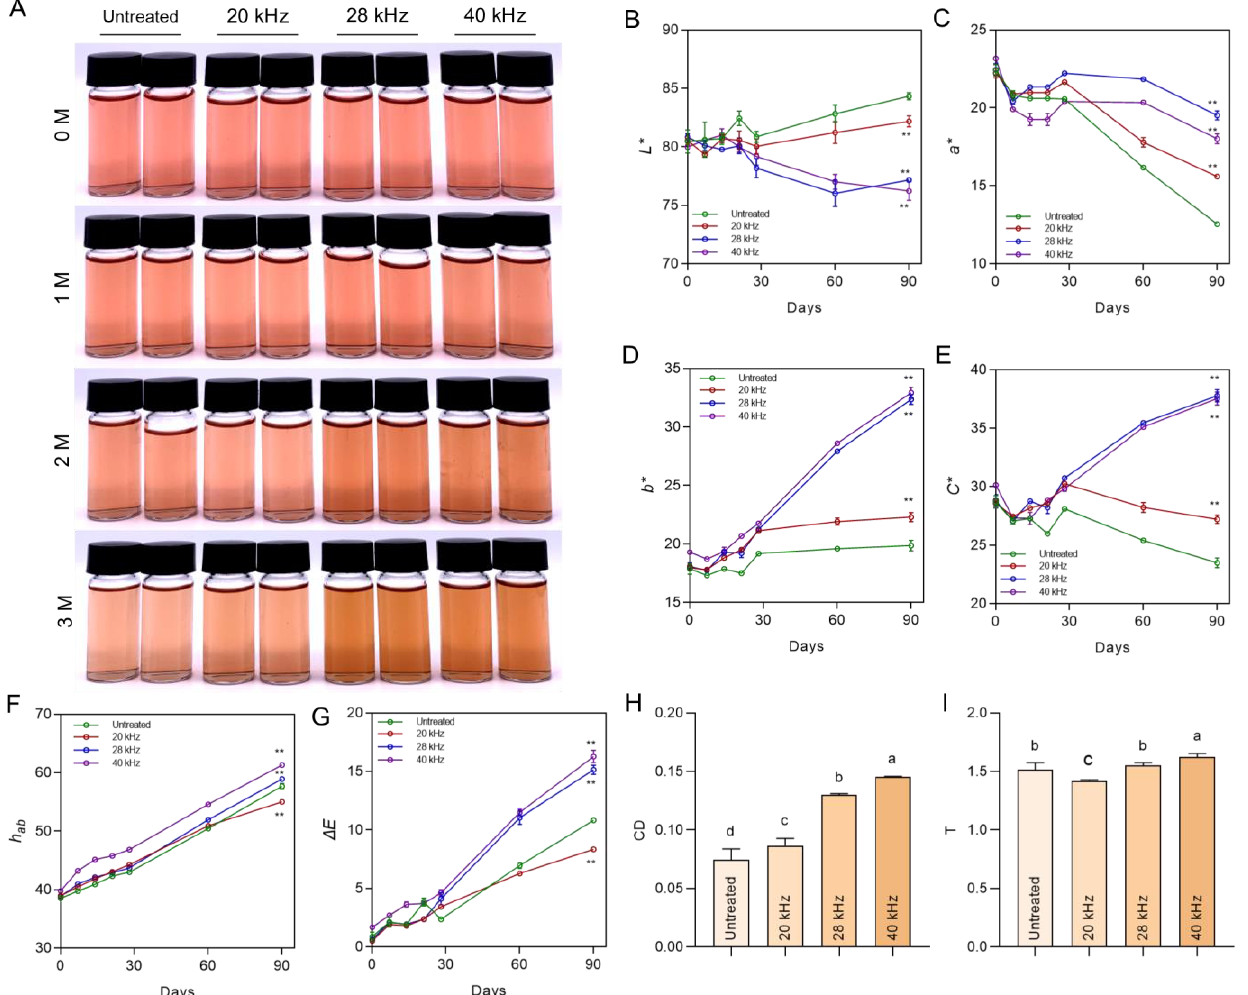
Figure 1. Color characteristic index of Sanhua plum wine during the whole aging period. ( A ) Representative image of fermentation solution. The images were captured with the same camera parameters under uniform lighting conditions. ( B – G ) CIE-LAB tristimulus color assessment results. ( H ) The color intensity of three-month aging samples. ( I ) Color tonality of three-month aging samples. ** p < 0.01, compared with untreated wine. For color intensity and color tonality, different letters indicate a significant difference between the groups.